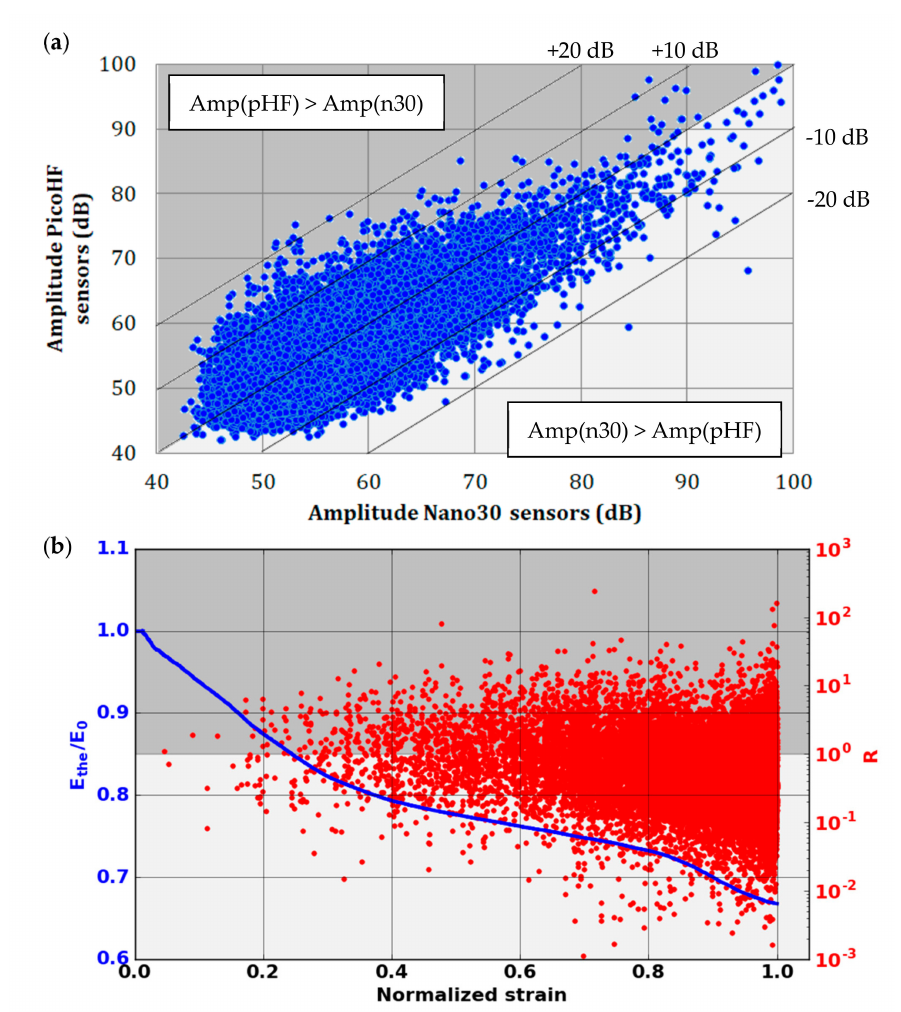
Figure 15. ( a ) Amplitude of the same signals recorded by Nano30 and PicoHF sensors, before the combination, in the plane Amp(Nano30) versus Amp(PicoHF) and ( b ) evolution of the coe ffi cient R versus strain during the macroscopic tensile test in fiber orientation.